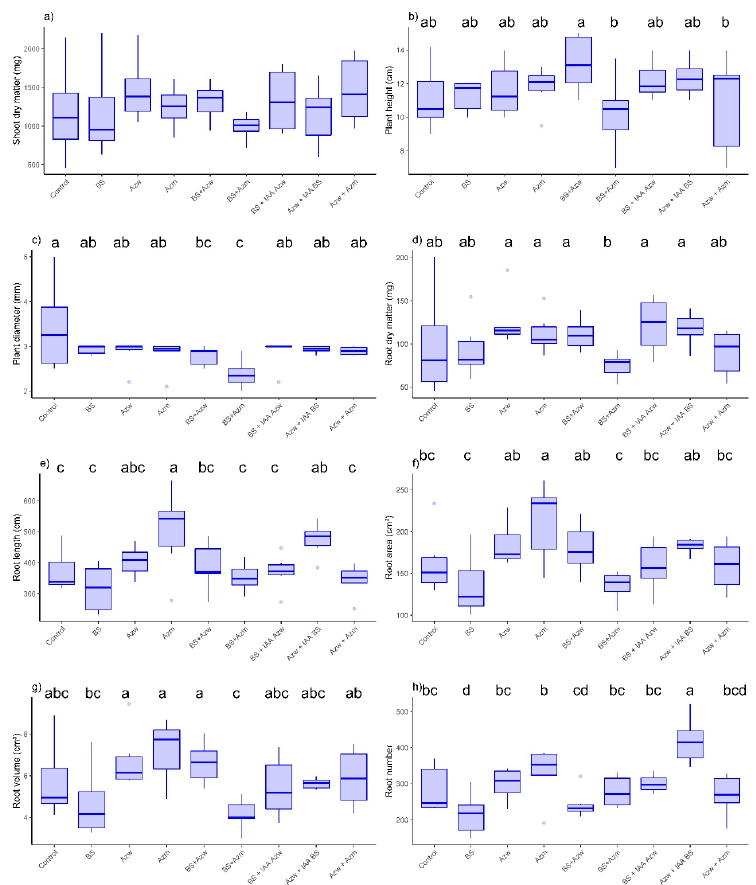
Figure 1. Boxplots for growth evaluation of Micro-Tom tomato plants inoculated with auxin- synthesizing bacteria. ( a ) shoot dry mass, ( b ) plant height, ( c ) plant diameter, ( d ) root dry matter, ( e ) root length, ( f ) root area, ( g ) root volume, ( h ) number of roots. Means followed by the same lowercase letter or absence of letters do not differ by Tukey’s test ( p < 0.05). Control, without inoculation; BS, B. subtilis; Azw, A. brasilense wild; Azm, A. brasilense mutant; BS + Azw, B. subtilis + A. brasilense wild; BS + Azm, B. subtilis + A. brasilense mutant; BS + IAA Azw, B. subtilis + exogenous auxin (400 µ g mL − 1 ); Azw + IAA BS, A. brasilense + exogenous auxin (30 µ g mL − 1 ); Azw + Azm, A. brasilense wild + A. brasilense